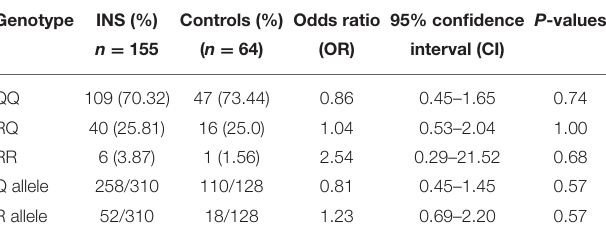
TABLE 4 | Genotype and allele frequencies of Interleukin-13 gene polymorphism in Kuwaiti children with INS and controls. Genotype INS (%) Controls (%) Odds ratio 95% confidence P -values